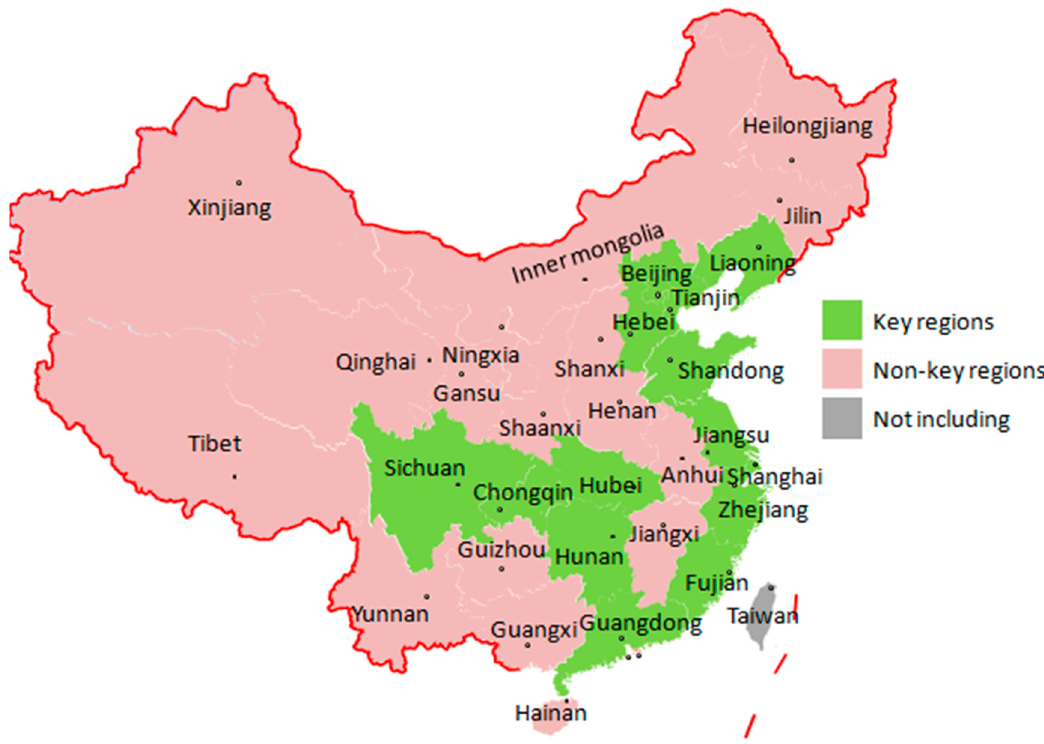
Figure 1. Key and non-key regions under Guiding Opinions 2010.